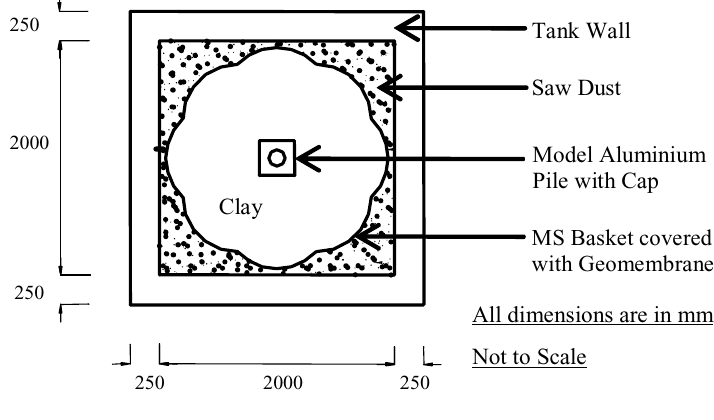
Fig. 2. Simulated elastic half